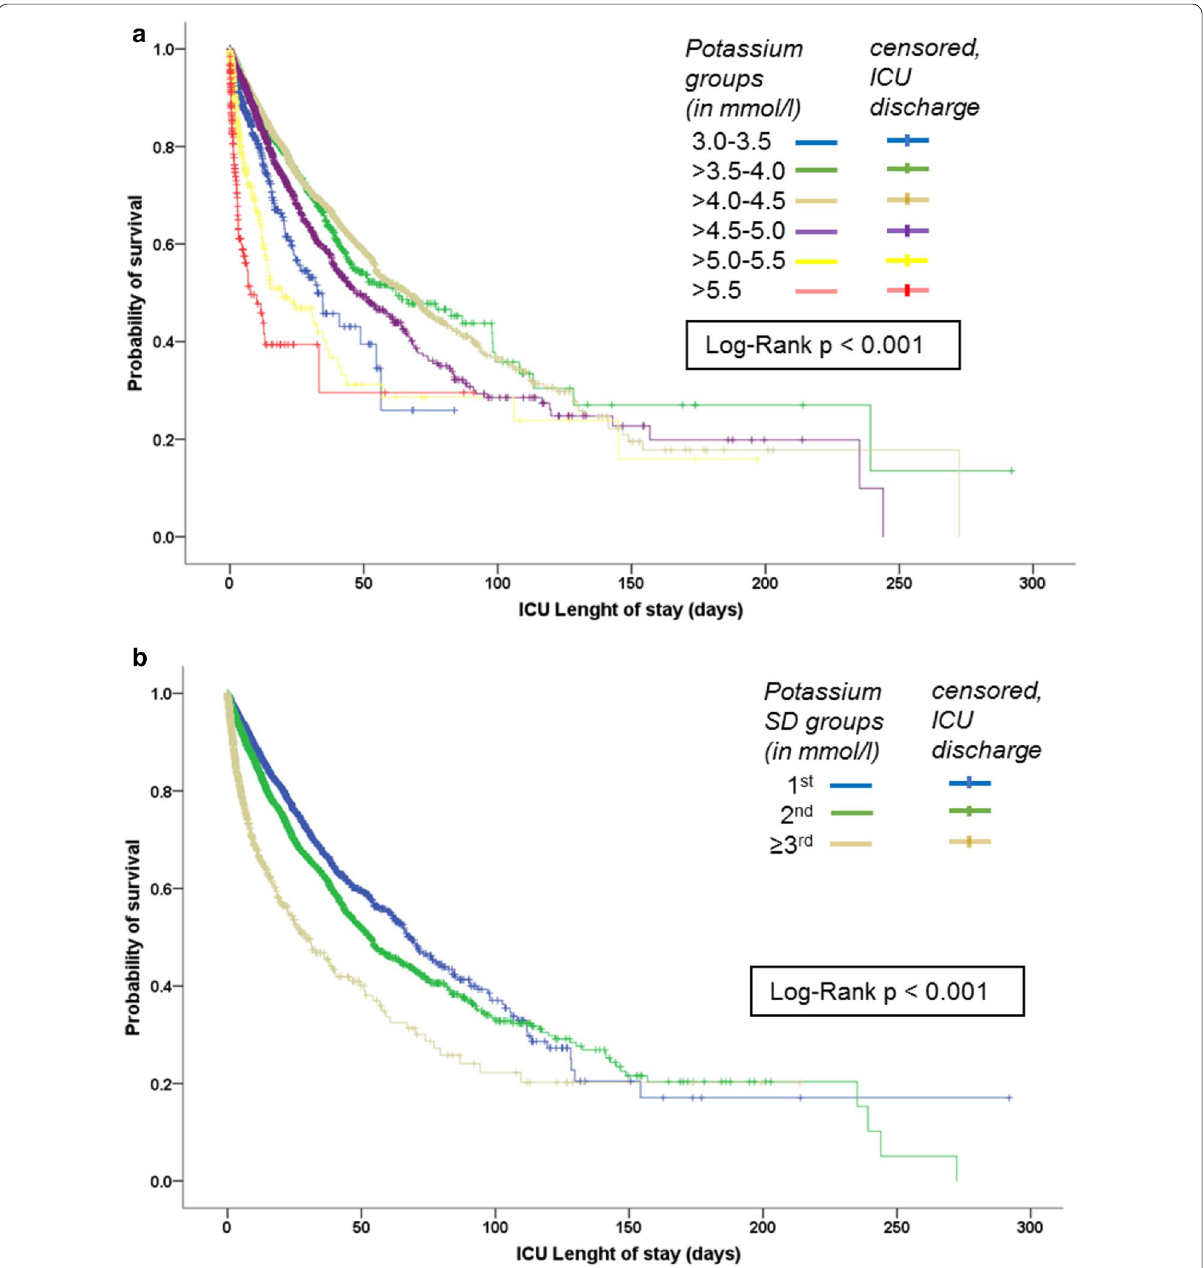
Fig. 2 Kaplan–Meier curves. Survival curves show probability of survival at hospital discharge for ( a ) mean potassium groups and ( b ) potassium variability groups (in SD), tested by Log‑Rank